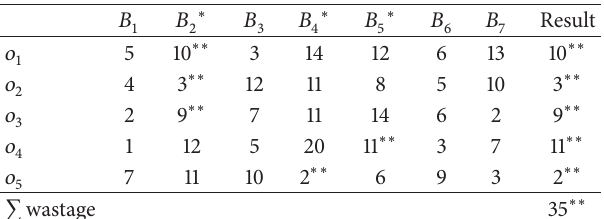
Table 2: Graphical representation of cost matrix 𝑐 and selection